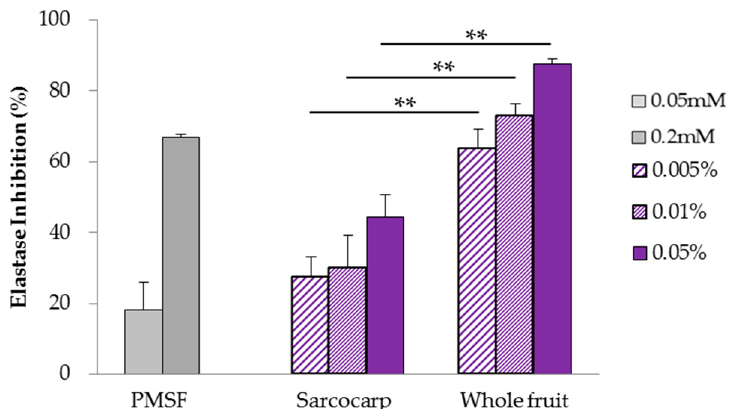
Figure 1. Elastase inhibition effect of the aqueous extracts from C. sinensis . Equal quantities of sarcocarp and whole fruit extracts were dissolved in the buffer to the appropriate concentration, and the elastase inhibition was determined. The sample concentration is described as the solid concentration. Results are expressed as the mean ± SD (n = 3) (** p < 0.01).